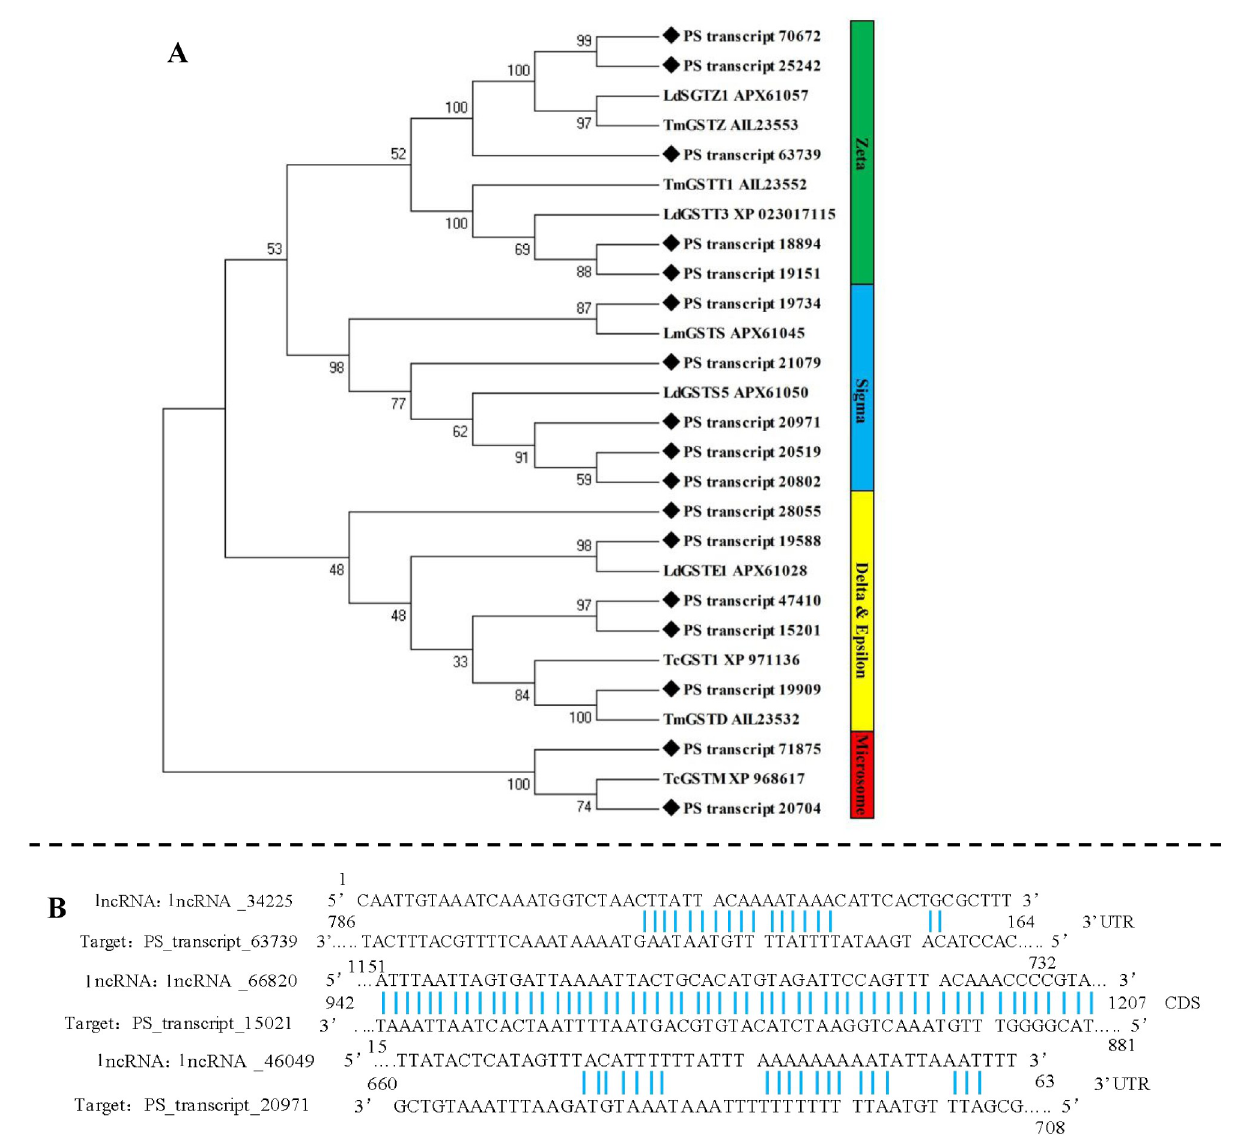
Fig 4. Sequence analysis, regulatory lncRNA, and splicing events of GSTs. A. Phylogenetic analysis of transcripts encoding GSTs; B. binding sites of lncRNA and GSTs; C. splicing events of GSTs.